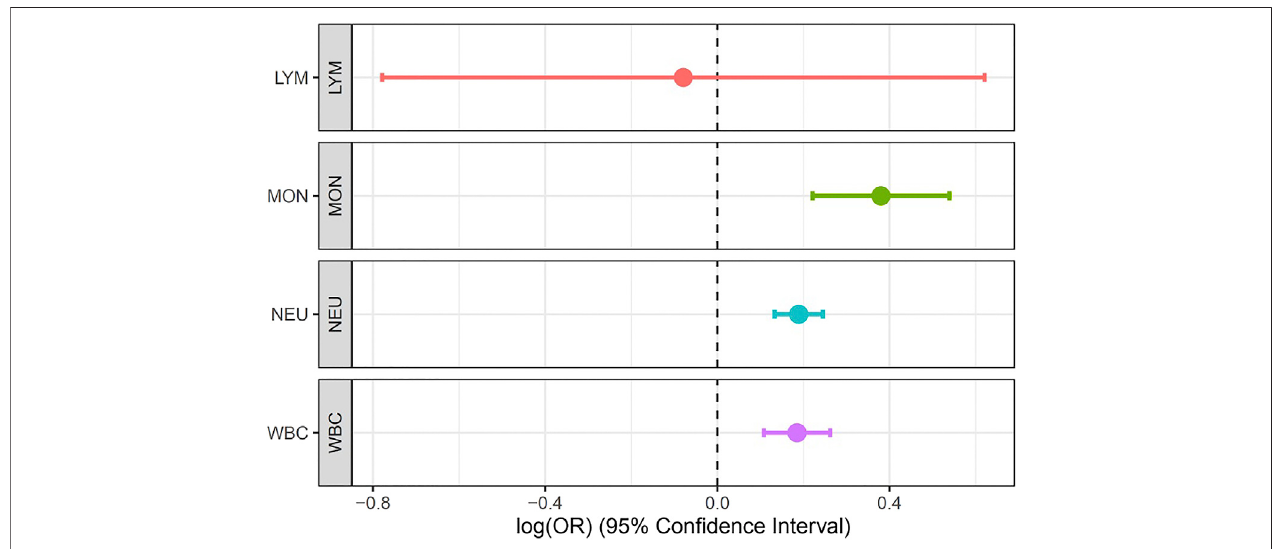
FIGURE 4 | Forest plot for the association between Lym, Mon, Neu, and WBC with asthma estimated using MR-IVW method.